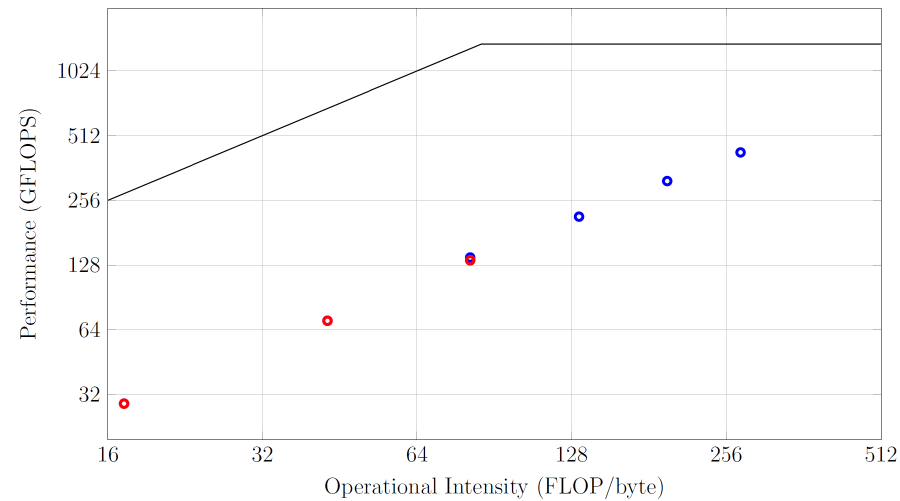
Figure 9. Roofline model HARP platform. The red dots indicate the performance of the floating-point kernel for different values of radius r = 1,2,3 while the blue dots indicate the performance of the fixed-point implementation for radii r =